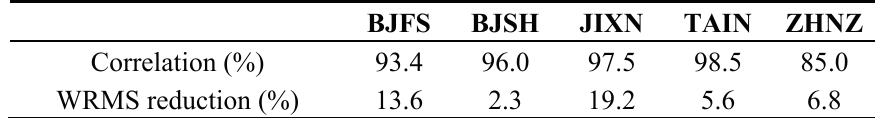
Table 3. Correlation between GPS and GRACE derived seasonal variations and WRMS reduction ratio of all selected GPS sites after removing GRACE-derived elastic deformation from GPS time